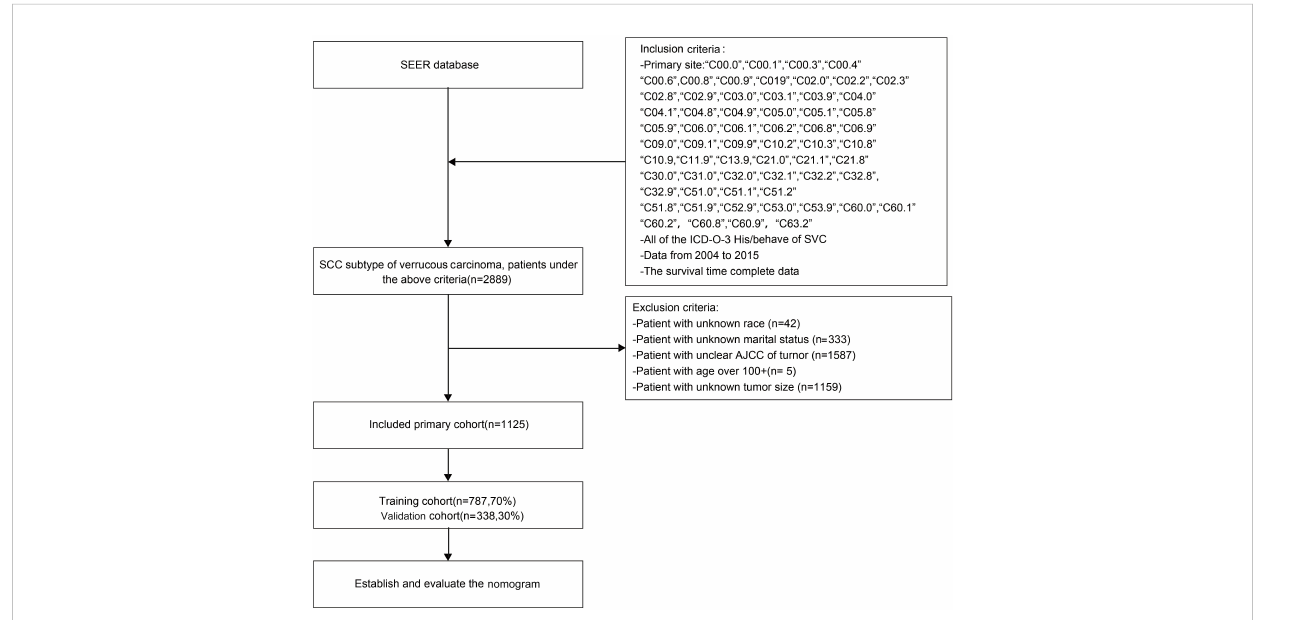
FIGURE 1 Flow chat of research selection. SEER, Surveillance, Epidemiology, and End Result Program; ICD-0-3, International Classi fi cation of Disease for Oncology, Third